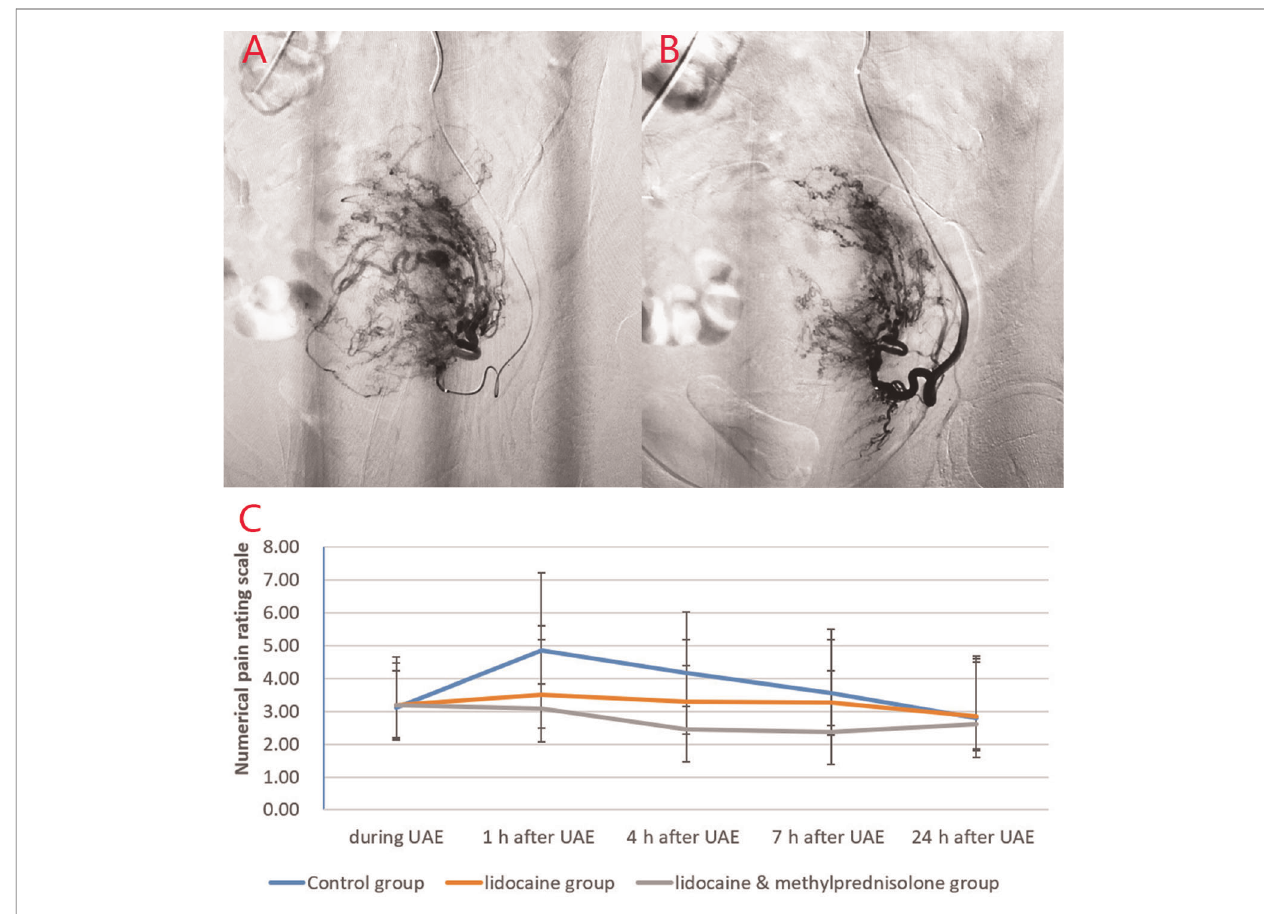
FIGURE 3 | Images from a patient in the study group and a patient in the lidocaine group. ( A ) Before lidocaine injection and ( B ) after lidocaine injection. Left uterine arteriography images show uterine artery spasm after lidocaine injection, as indicated by the white arrow. ( C ) Pain score curve of the three